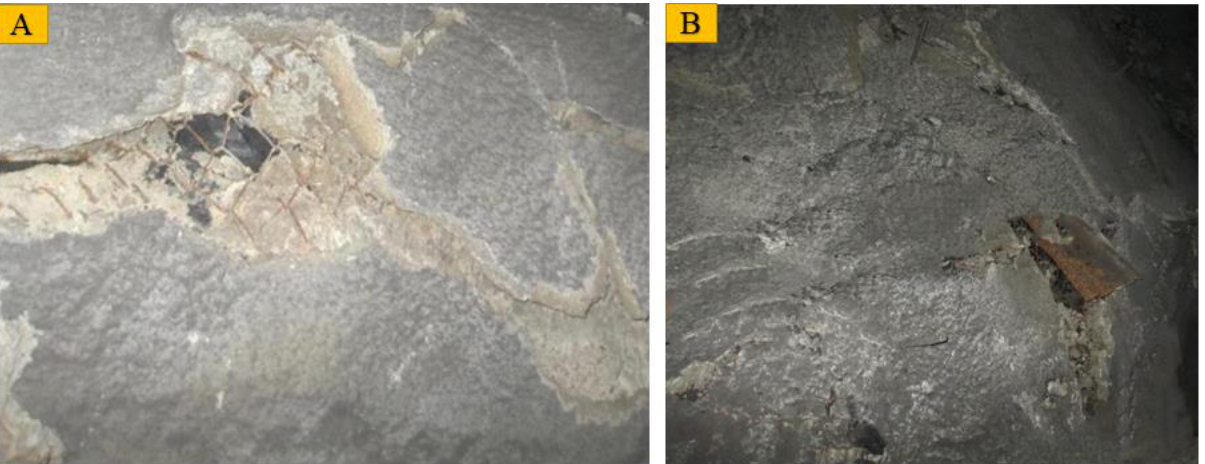
Figure 4. Asymmetric damage of the main roadway after stopping mining. ( A ) main return-air road- way, and ( B ) main haulage